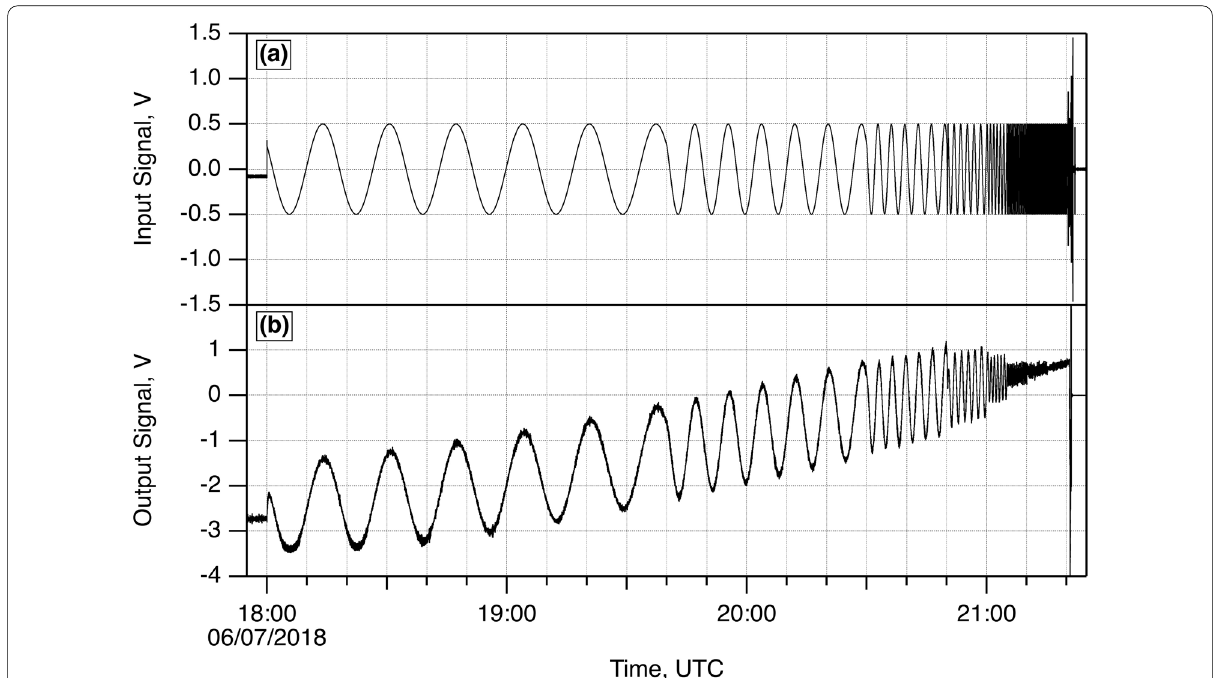
Fig. 4 Time series data acquired in the signal injection experiment. a input signal. b output